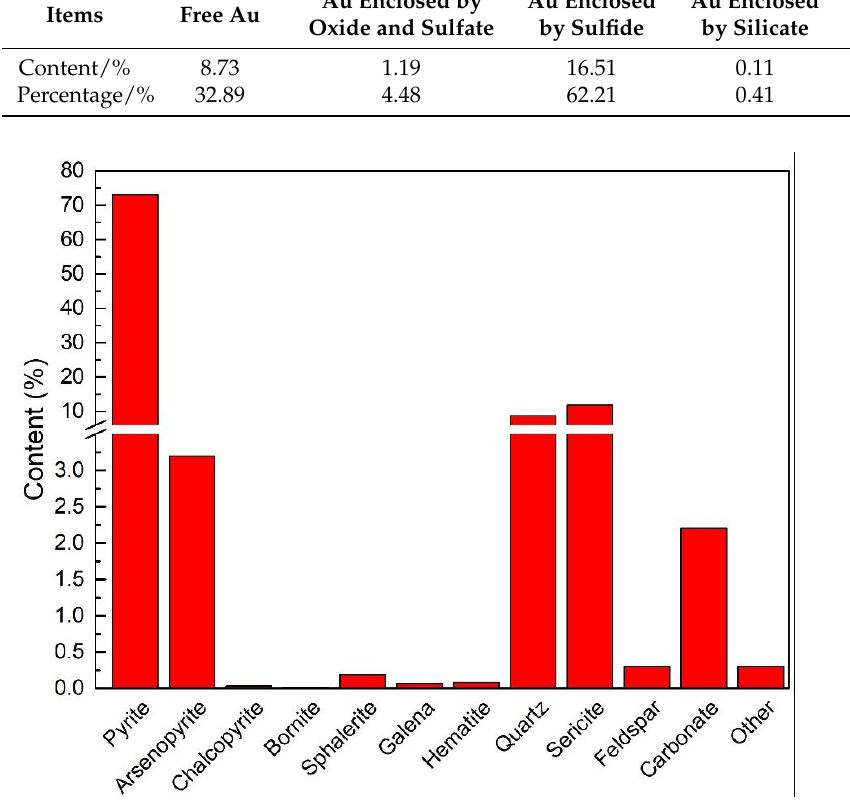
Figure 1. Mineral composition in refractory gold concentrate.